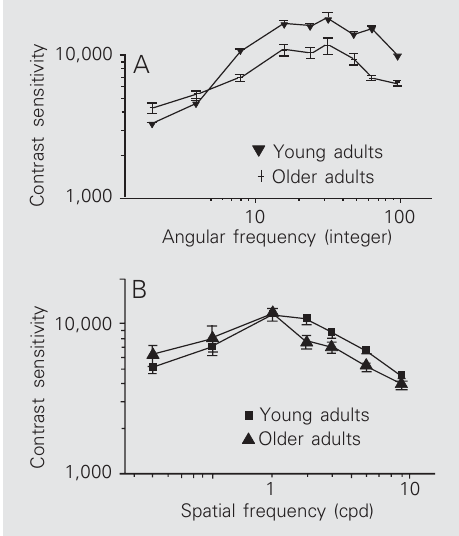
Figure 2. Angular frequency sen- sitivity functions for young and older adults (A) and spatial fre- quency contrast sensitivity for vertical sine-wave gratings for the two groups (B). Reported data are the grand mean for 6 individuals in each